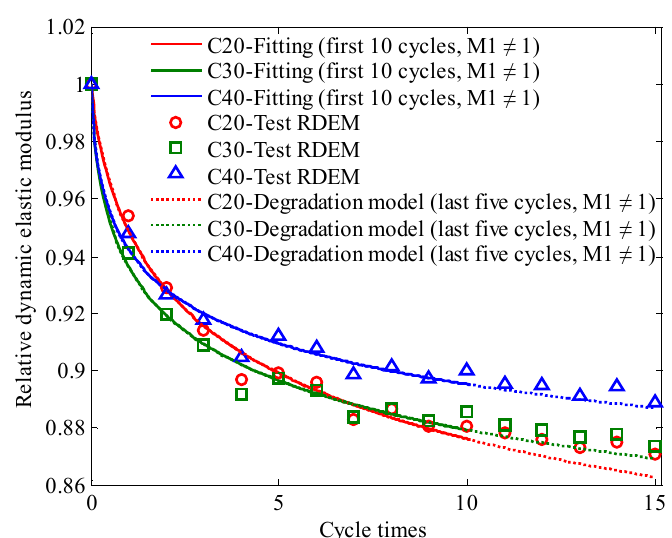
Figure 7. Results from the dynamic elastic modulus degradation model. (Notes: ‘Degradation model’ means the data are calculated based on the dynamic elastic modulus degradation model; ‘last five cycles’ means the data are form the last five cycles of periodic temperature-humidity action in the dynamic elastic modulus test of concrete).